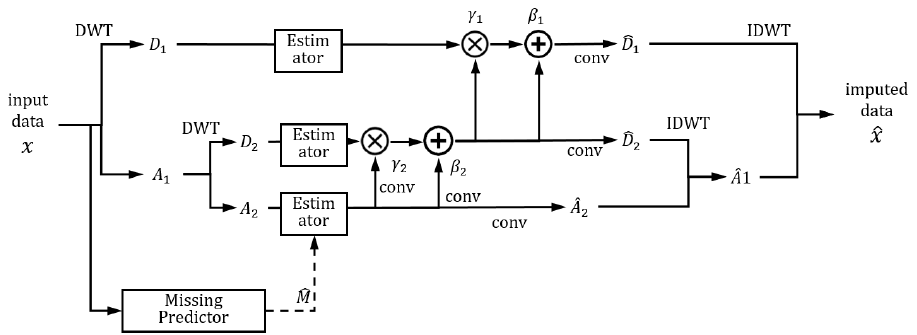
Figure 7. Details of the proposed imputer